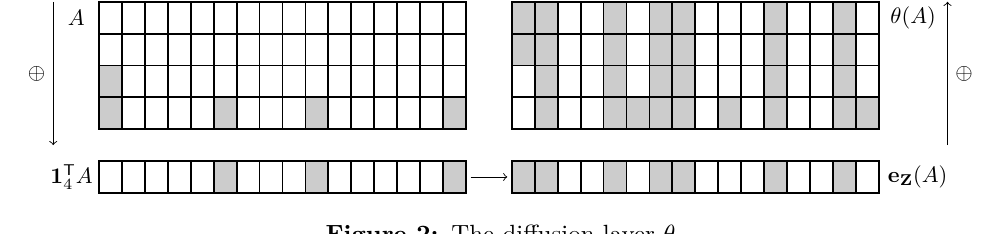
Figure 2: The diffusion layer θ .